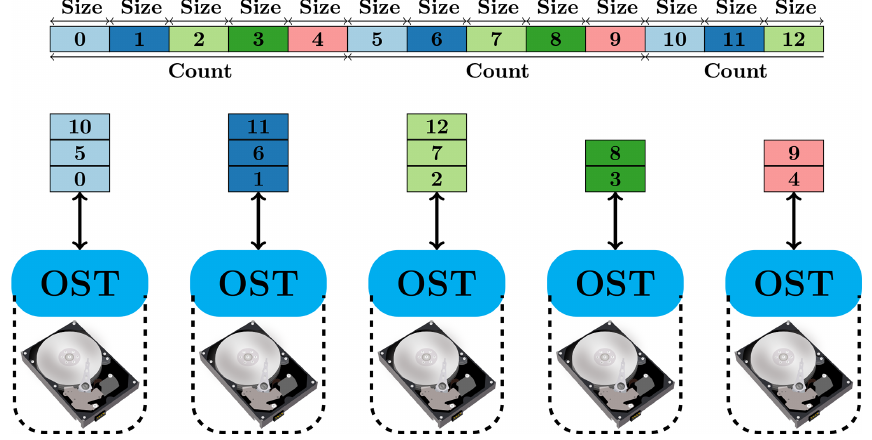
Figure 5. Schematic diagram of the striping of a file across multiple OSTs in a Lustre parallel file system. The “size” and “count” are the abbreviations of “stripe size” and “stripe count”, respectively. In this example, the stripe count is five and the file is divided into 12 segments of a size equal to the stripe size. The number is the ID of a